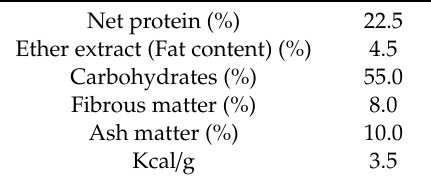
Table 1. Nutritional composition of the standard chow (CTL) fed to rats after